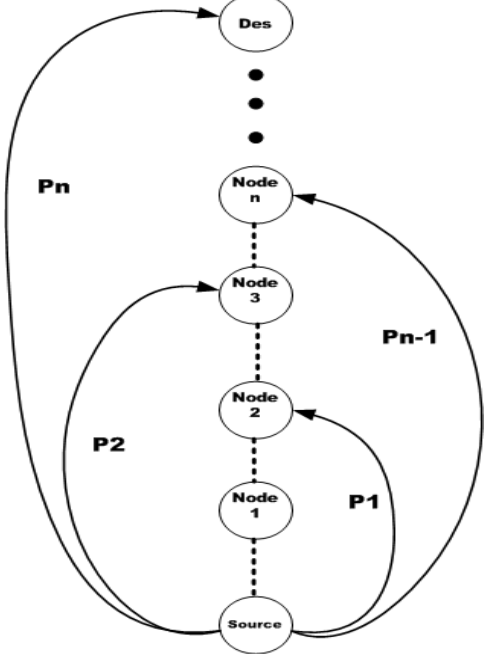
Figure 12. Jumping Transmission in